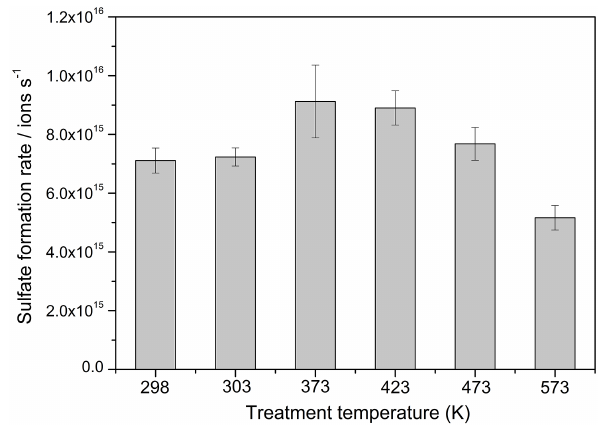
Figure 8. Sulfate formation rates on 30mg of FN-24 after exposure to 3ppm SO 2 under different pretreatment